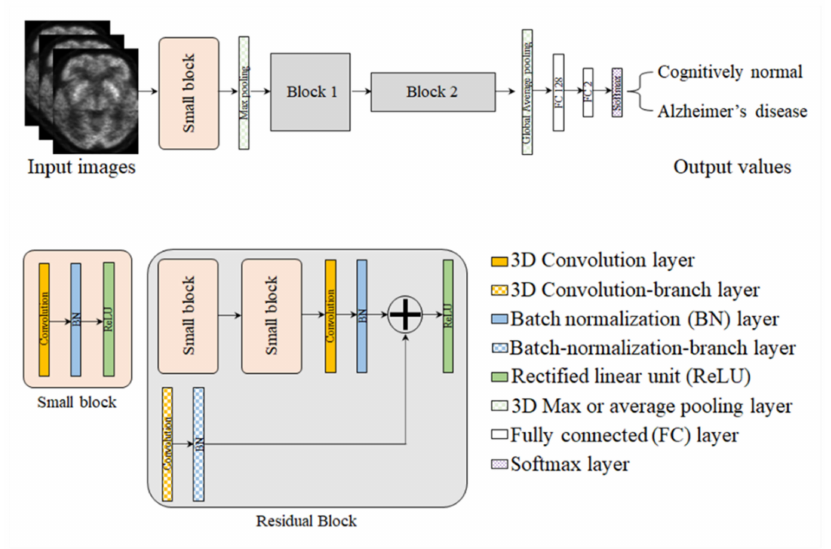
Figure 5. The structure of the proposed network. Most network parameters used in this study are consistent with the notations in this